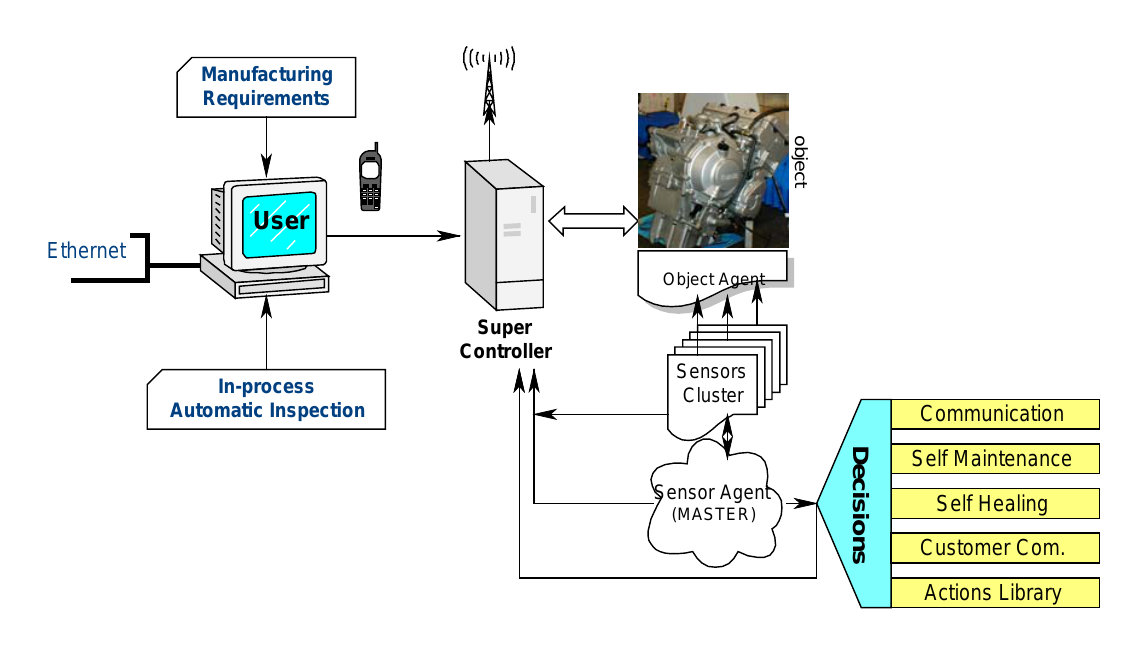
Figure 12. Intelligent sensor cluster